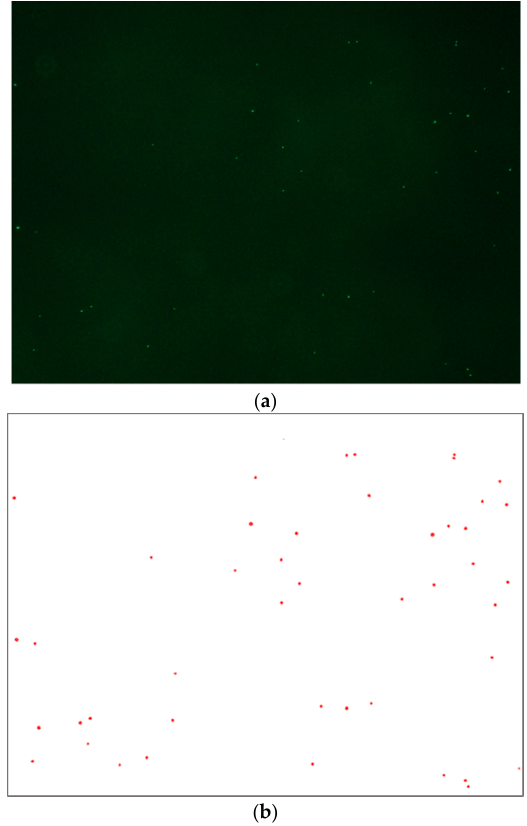
Figure 3. Image for fluorescent biotinylated Polystyrene (PS) bead bound to streptavidin on the surface of the micro-channel ( a ) from fluorescent microscopy ( b ) after image processing for counting the bound